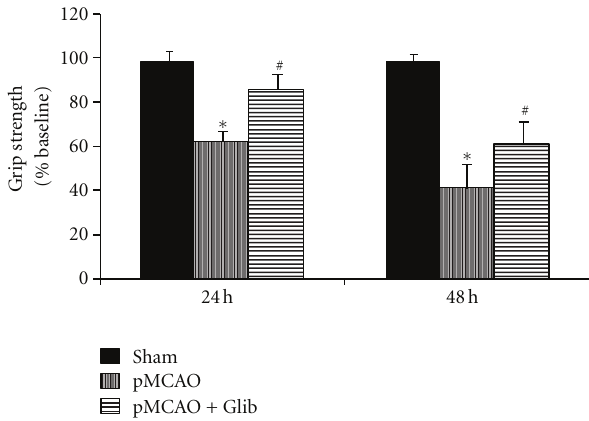
Figure 4: Glib improves grip strength in a rat model of pMCAO. The rats subjected to pMCAO + vehicle showed significantly ( P < 0.05) lower grip-strength scores at both time points compared to sham + vehicle rats. Glib-treated rats showed significantly ( P < 0.05) improved average scores at both time points (24 and 48 h after injury) compared to pMCAO + vehicle-treated animals. P < 0.05; ∗ significant di ff erence compared to Sham + Vehicle, #significant di ff erence compared to pMCAO + Vehicle. Values are expressed as mean ±